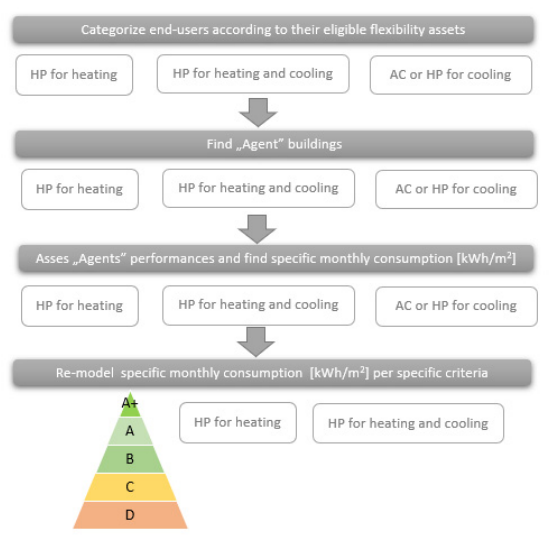
Figure 4. Baseline analysis and modelling of monthly flexible load consumption.